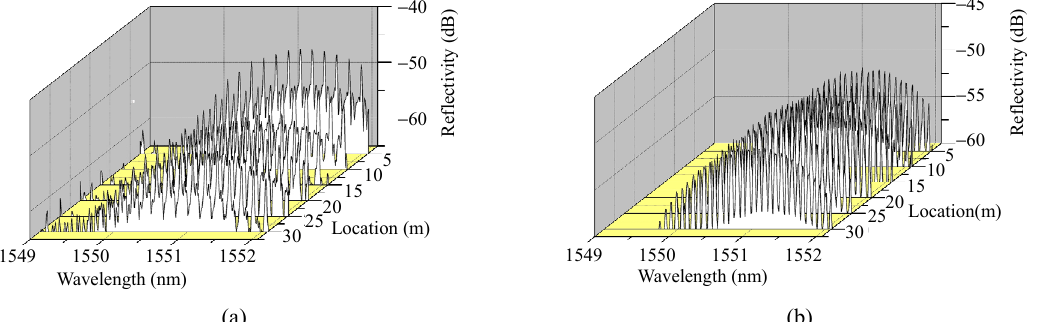
Fig. 4 Reflection spectra of SFGs array with different parameters: (a) a = 0.4 mm, p = 4 mm, and L = 40 mm; (b) a = 0.4 mm, p = 10 mm, and L = 100 mm.